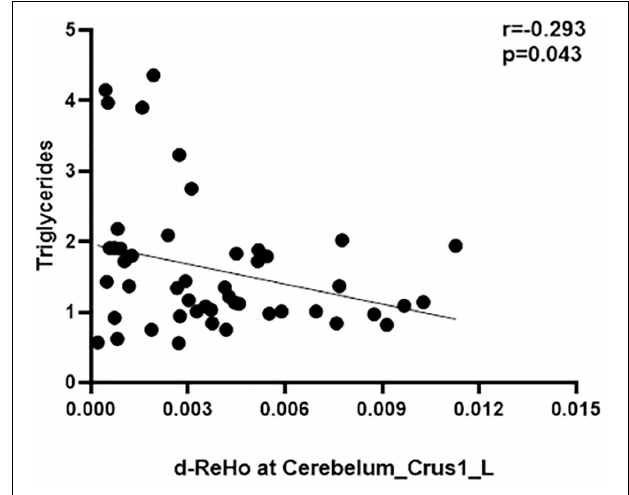
FIGURE 3 | Correlation between d-ReHo variability of the Cerebelum_Crus1_L and the triglycerides score.